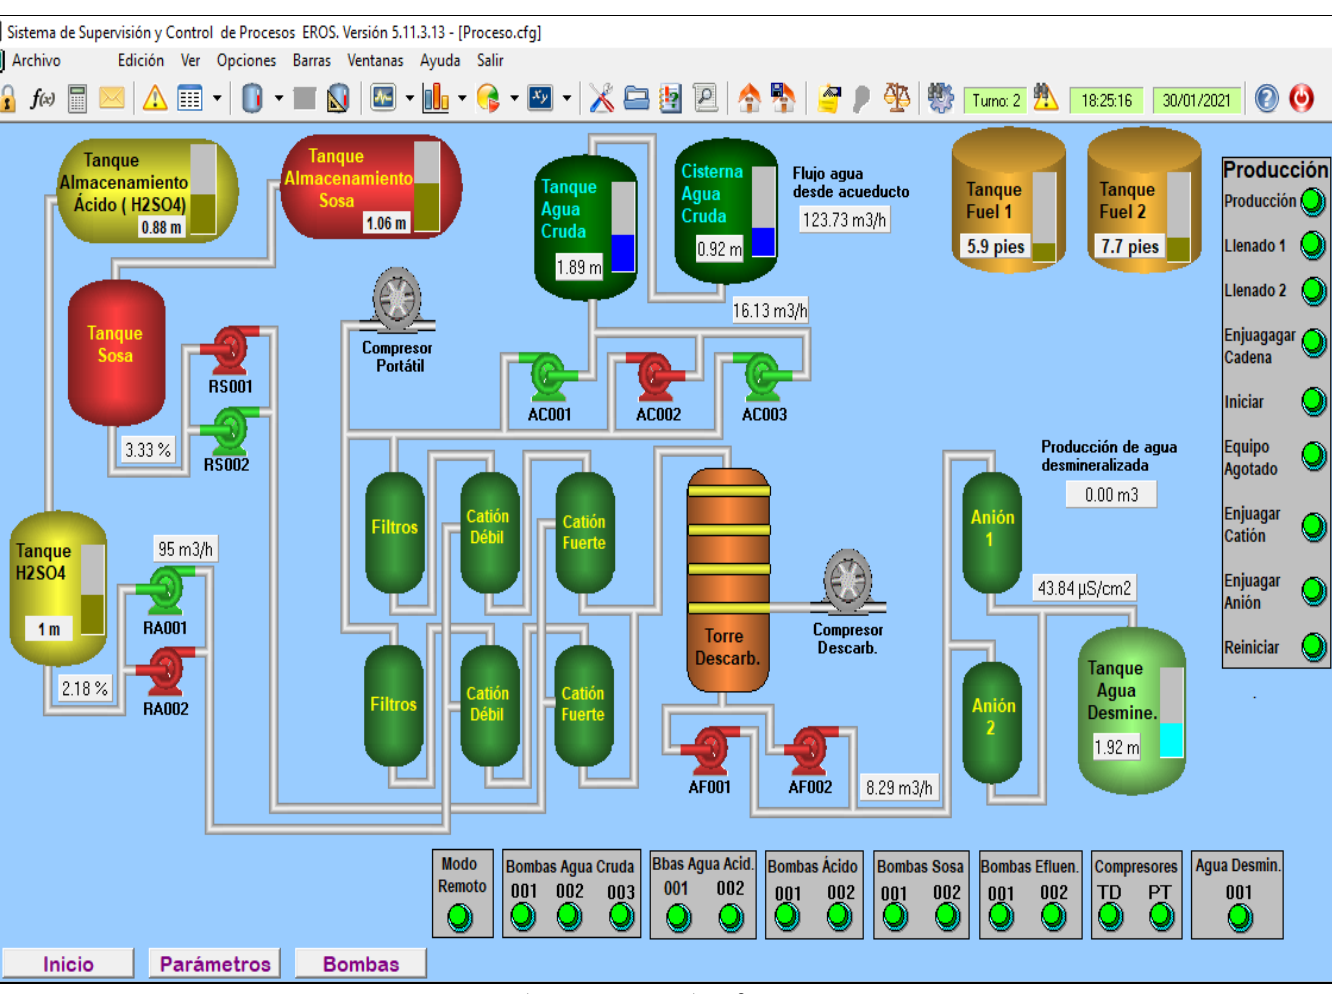
Figure 7: Process